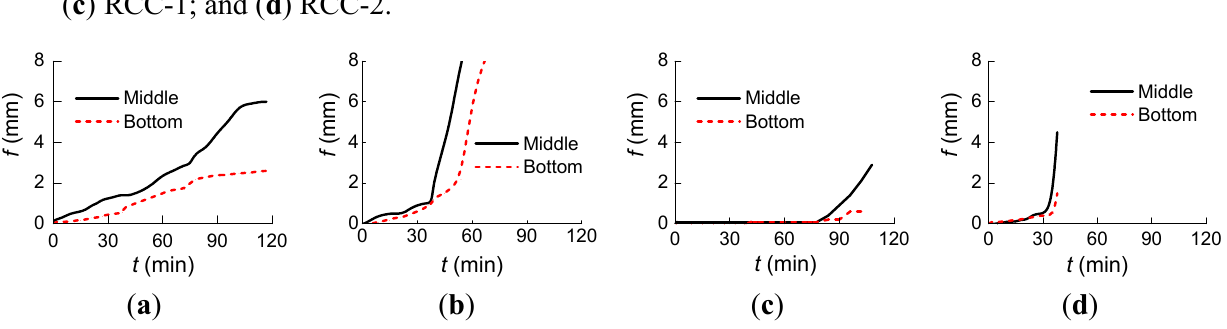
Figure 10. Curves of “lateral deflection to time” of specimens: ( a ) NCC-1; ( b ) NCC-2;